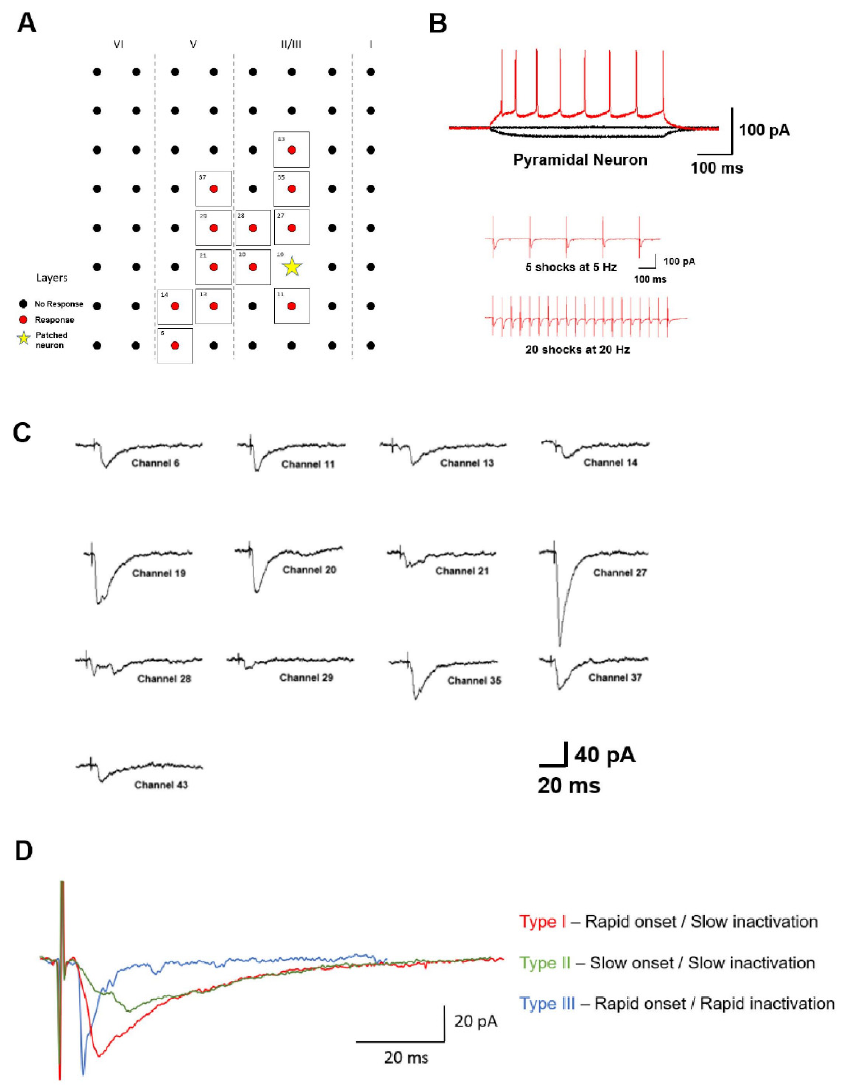
Figure 2. ACC pyramidal neurons receive heterogeneous inputs: ( A ) A representative mapping of a neuronal network within the ACC. The yellow star represents the patched neuron, while the red dots represent channels that elicit a response in the patched neuron when stimulated. Representative traces (right) of the responses recorded in the patched neuron when stimulations were given to different channels. ( B ) Identification of pyramidal type by injecting step currents ( − 50, 0, and 50 pA). Monosynaptic connectivity was tested using 5 shocks at 5 Hz and 20 shocks at 20 Hz. Responses triggered without failure in the presence of picrotoxin (100 µM) indicate monosynaptic connectivity. ( C ) Sample traces from the recorded neuron show responses with different characteristics. ( D ) Three representative traces are depicted to illustrate the three different types of response kinetics that were observed: Type 1—Rapid onset followed by a slow inactivation phase illustrated in red, Type II — Slow onset followed by a slow inactivation phase illustrated in green, and Type III — Rapid onset